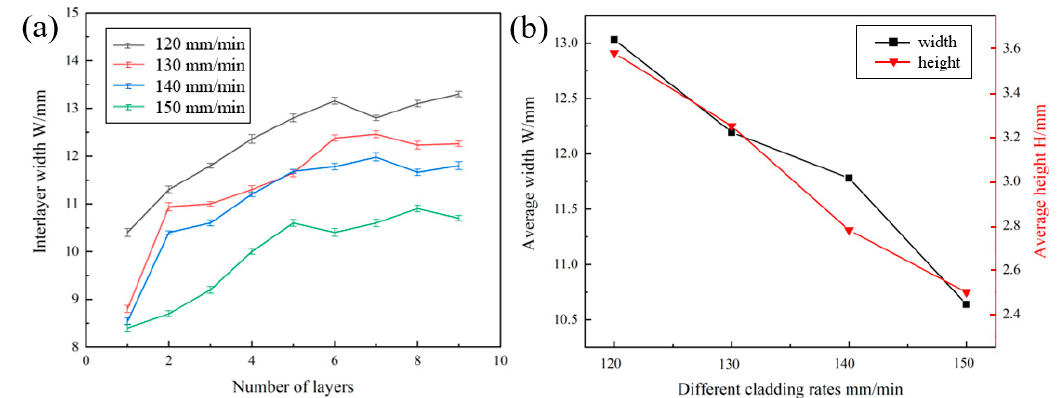
Figure 11. Variation of specimen layer width at different melting rates ( a ) number of specimen layers and width between layers, ( b ) deposition rate and average width and height.